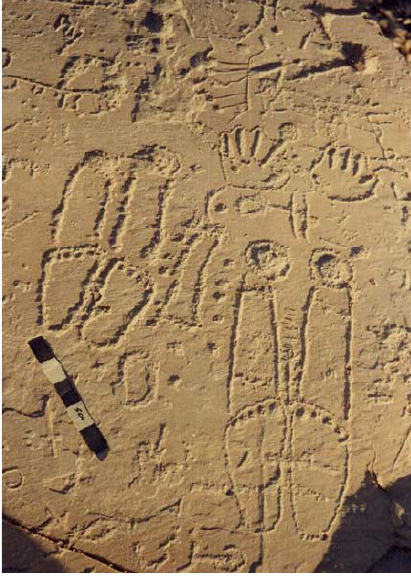
Figure 30. This example of symbolic arrangements, including hand and foot motifs and series of cupules (cup marks), is located near Sakkaka, northern region of Saudi